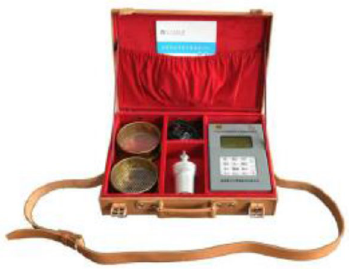
Figure 10. Coal seam gas content measuring device.